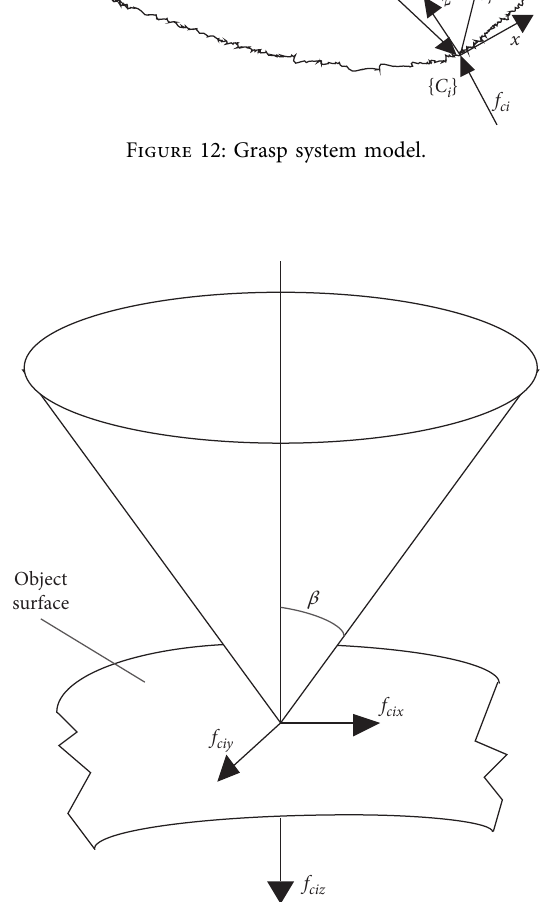
Figure 13: Friction model of the contact